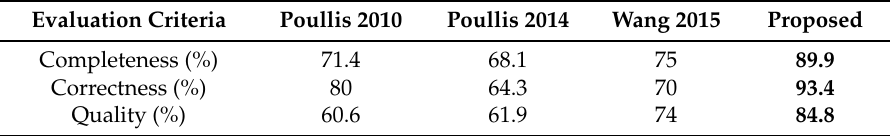
Table 2. Quantitative comparison of the proposed method with three other methods in the second study